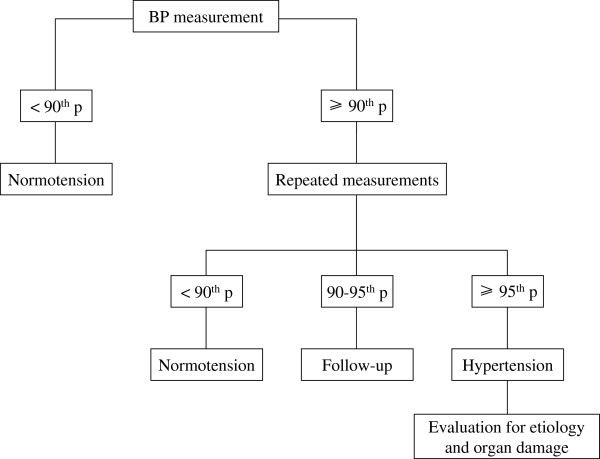
Diagnostic algorithm of hypertension in children and adolescents.